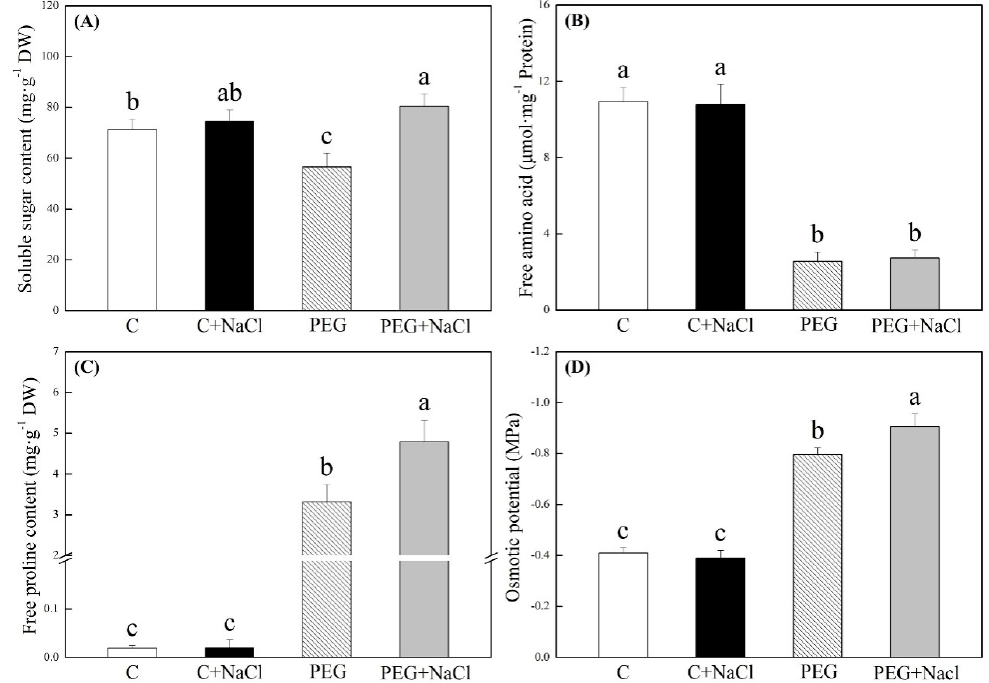
Figure 4. Effects of seeds soaking with water or NaCl (1 mM) on ( A ) soluble sugar, ( B ) free amino acid, ( C ) free proline, and ( D ) osmotic potential after seven days of germination under normal condition and water stress induced by 19% polyethylene glycol (PEG) 6000. Vertical bars indicate ±SE of mean ( n = 6). Different letters above columns indicate significant difference ( p ≤ 0.05).